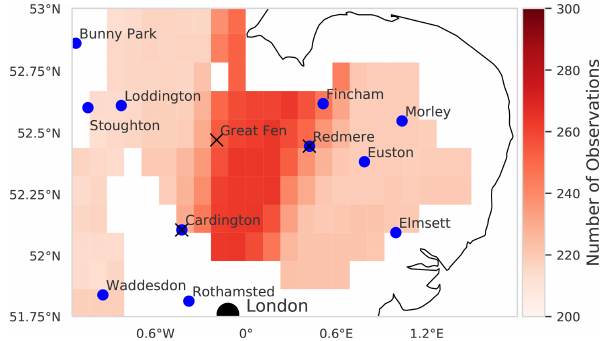
Figure 2. Location of COSMOS probes (blue circles) and flux tow- ers (black crosses) used in validation. Red shading indicates num- ber of SMAP observations assimilated in experiment period (2016). No colour corresponds to no observations being assimilated in that location due to low-quality retrieval or surface flag. The black dot shows the location of London,